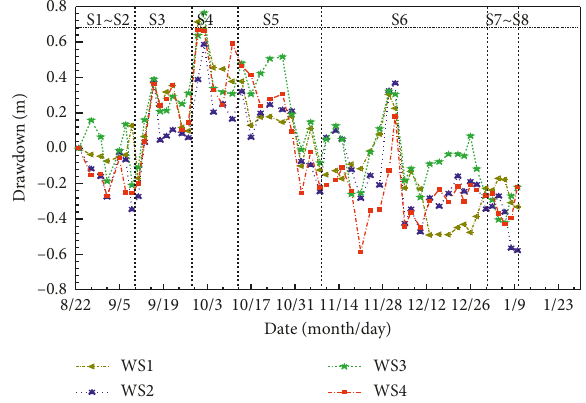
Figure 11: Variation of groundwater drawdown outside the excavation.